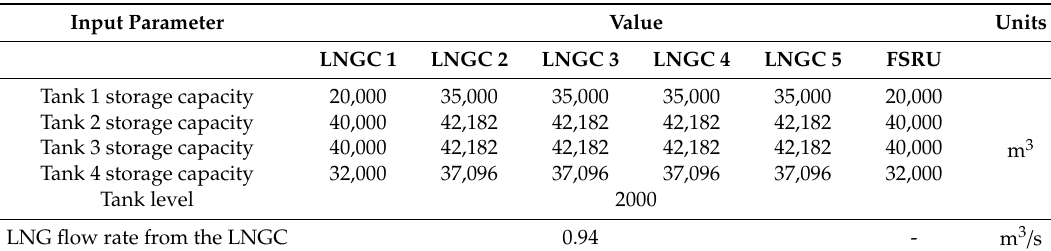
Table 2. Parameters for scenarios 1, 2 and 3.